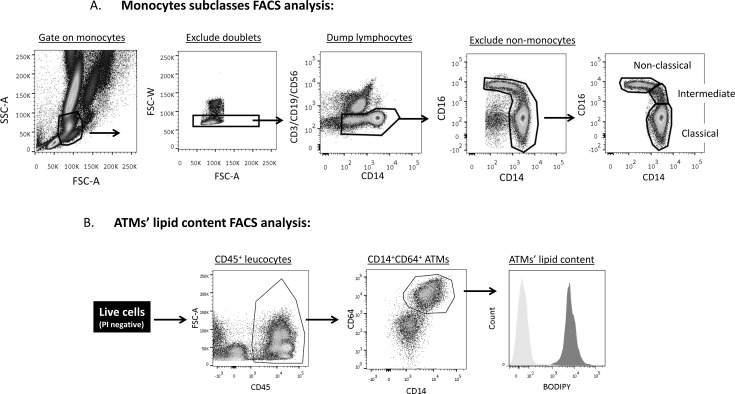
Analyses of circulating blood monocyte subpopulations and adipose tissue macrophage lipid content by FACS.A) Circulating blood monocytes subclasses: Following RBC lysis monocytes were identified by gating for small and low granular cells (low side scatter (SSC) and forward scatter (FSC), respectively), and cell doublets were excluded by using Area (FSC-A) vs. Width (FSC-W) signal intensity. T-, B- and NK- lymphocytes were excluded using CD3, CD19 and CD56, respectively. Monocyte subclasses were identified by CD14 and CD16 expression. B) Adipose tissue macrophage (ATM) lipid content: SVF was isolated from omental human fat tissues by mechanical and collagenase digestion. Viable ATM were identified as staining negative for propidium iodide (PI), positive for the leucocyte marker CD45, and positive for the macrophage markers CD14 and CD64. ATMs' lipids content was assessed using the neutral lipid fluorescent dye BODIPY readout, gray- unstained sample, black-stained sample.